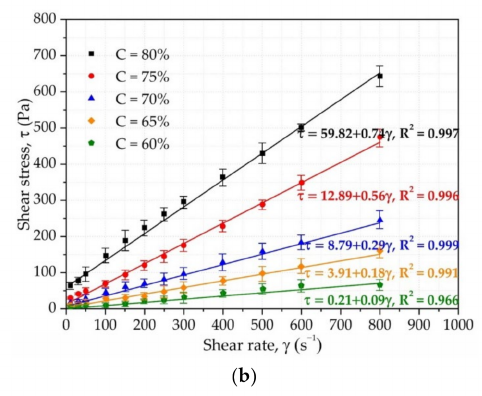
Figure 1. Testing apparatus and rheological results of slurry: ( a ) Rheometer testing apparatus; ( b ) Shear stress and shear rate relationships with fitted